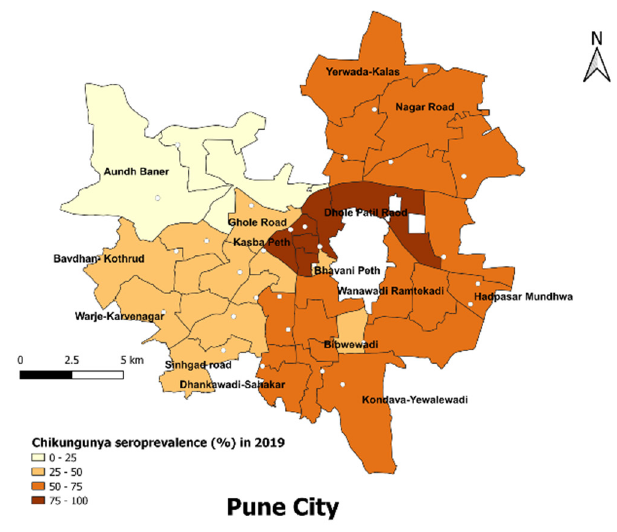
Figure 3. Seroprevalence (%) of chikungunya virus infection in 15 administrative zones of Pune City, 2019. The seroprevalence (%) of chikungunya virus infection is categorized and presented as different shades of orange; the highest seroprevalence is represented as dark brown and lighter shades depict lower seroprevalence levels. The vertical arrow indicates the north direction. The dots indicate the 30 cluster locations of the study.